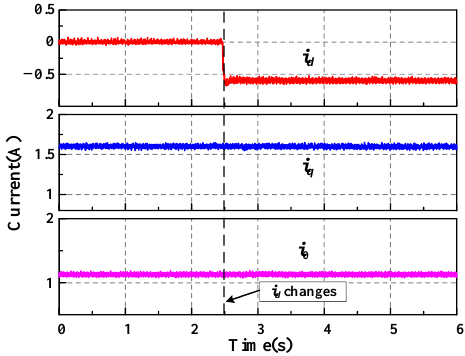
Figure 16. Current waveforms ( i d changes).